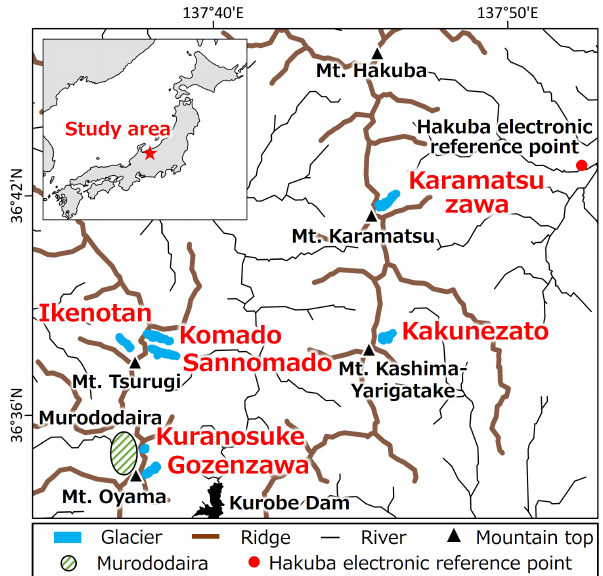
Figure 1. The location of seven glaciers in the northern Japanese Alps (names in red font).